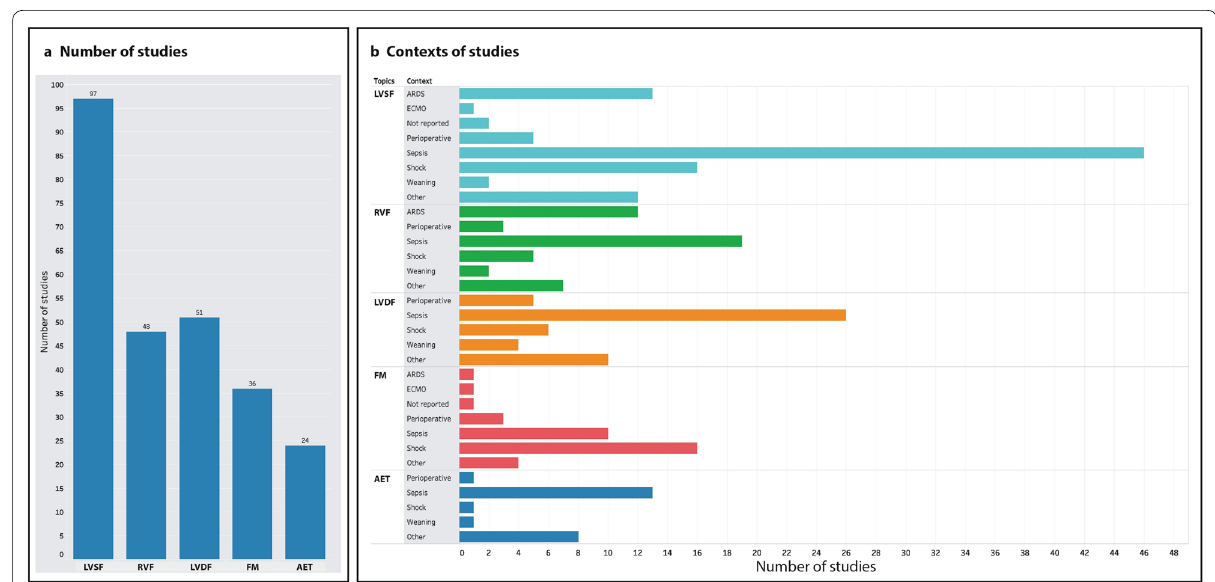
Fig. 2 Number ( a ) and clinical context ( b ) of the included studies included into the systematic review, per topics. AET advanced techniques, ARDS acute respiratory distress syndrome, ECMO extracorporeal membrane oxygenation, FM fluid management, LVDF left ventricular diastolic function, LVSF left ventricular systolic function, RVF right ventricular function